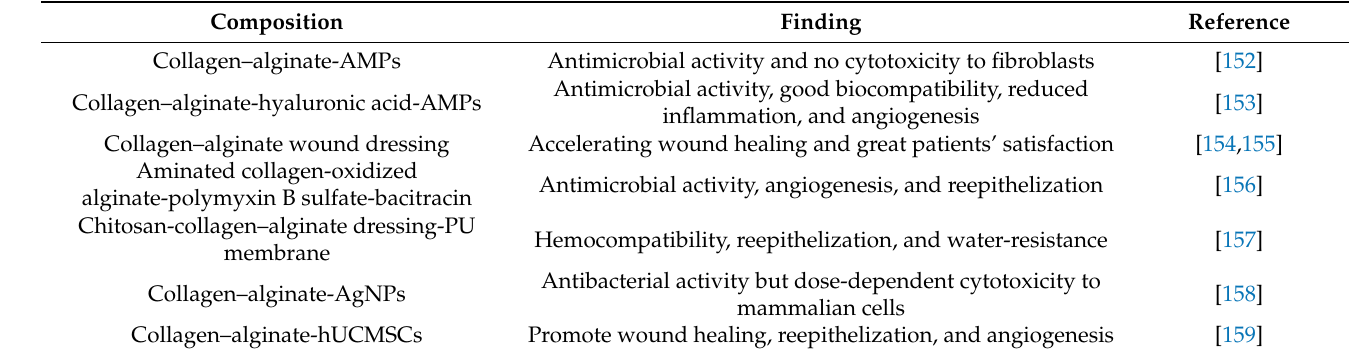
Table 4. Summary of CAC hydrogel in wound